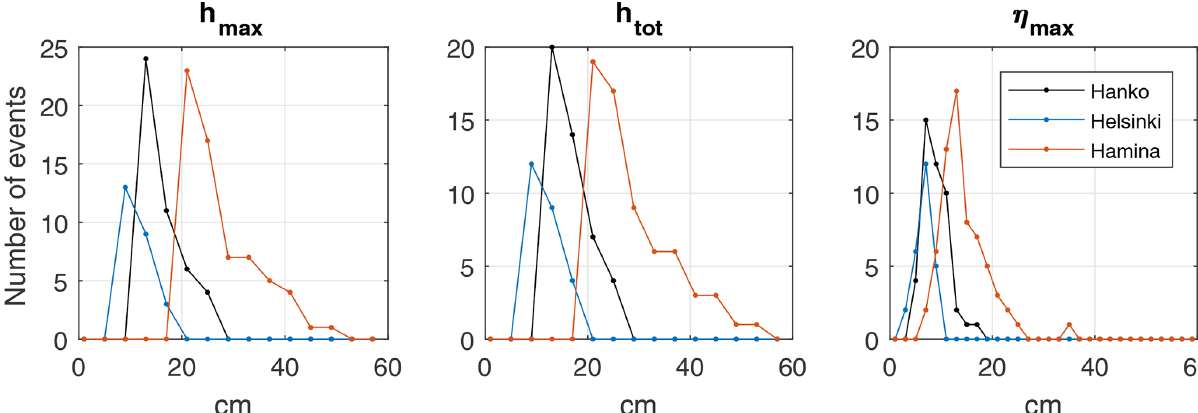
Figure 6. Histograms of meteotsunami heights, including both confirmed and potential events from all three stations: the maximum height of a single wave h max , the total range of variation h tot , and the maximum elevation η max . Table 2. Means of certain atmospheric variables on the years, months, or days when there is at least one meteotsunami occurrence and when there are none. The statistical significance of the difference is shown at 5% level. CG flash is cloud-to-ground flash, MSLP is mean sea level pressure, T 2m is temperature at 2m, D 2m is dew point temperature (at 2m), U 10m is wind speed at 10m, CAPE is the convective available potential energy, NAO is the North Atlantic Oscillation, and GoF is Gulf of Finland. Meteotsunami No meteotsunami Significance ( p